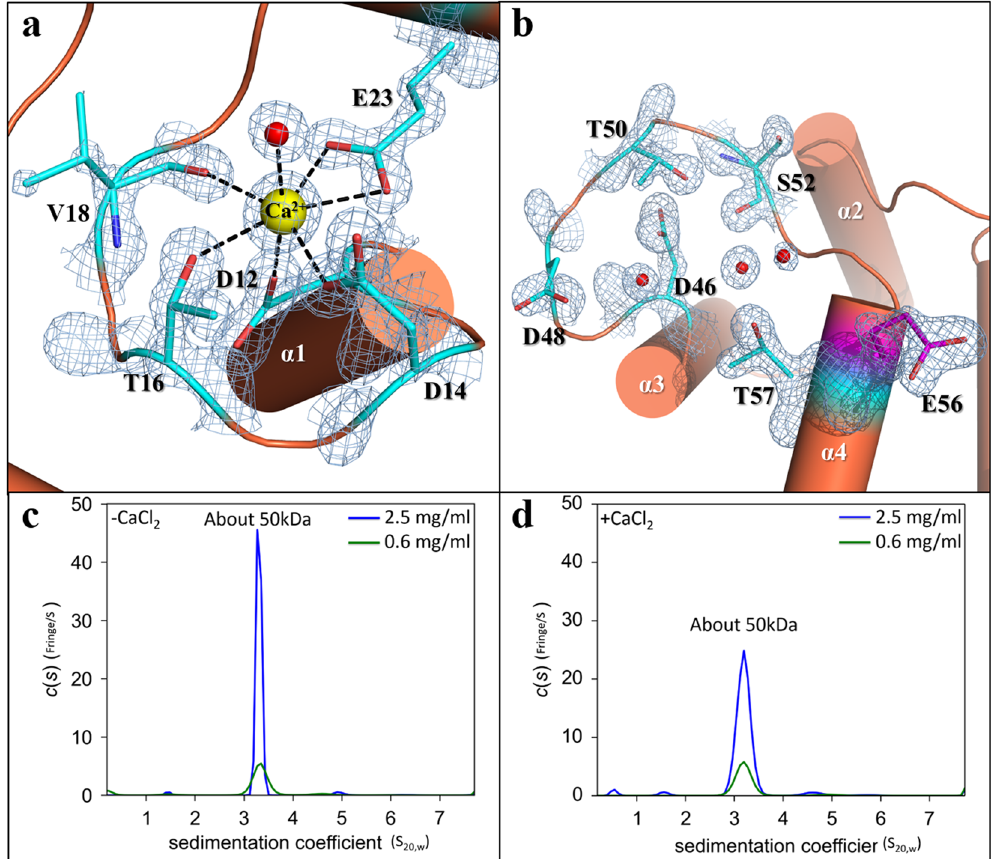
Figure 3. Structure of CB1 and CB2, and analytical ultracentrifugation analysis of CsTAL3 induced by a Ca 2 + ion. (a , b) Close-up view of the structure and the electro density map of CB1 and CB2. The yellow molecule represents a Ca 2 + ion and red molecules represent water molecules. (c , d) Results of analytical ultracentrifugation analysis of CsTAL3 induced by CaCl 2 . The X direction means a sedimentation coefficient at 20 °C in pure water ( S 20,w ), and the Y direction means continuous distribution, c(s)